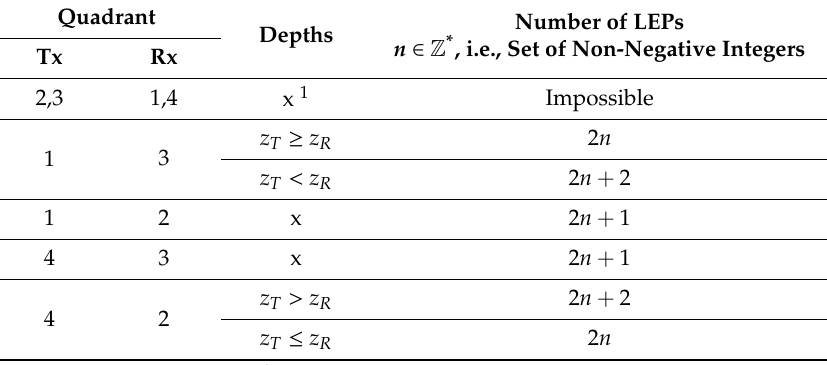
Table 1. Ray classification based on node depths and quadrants of the transmitted and